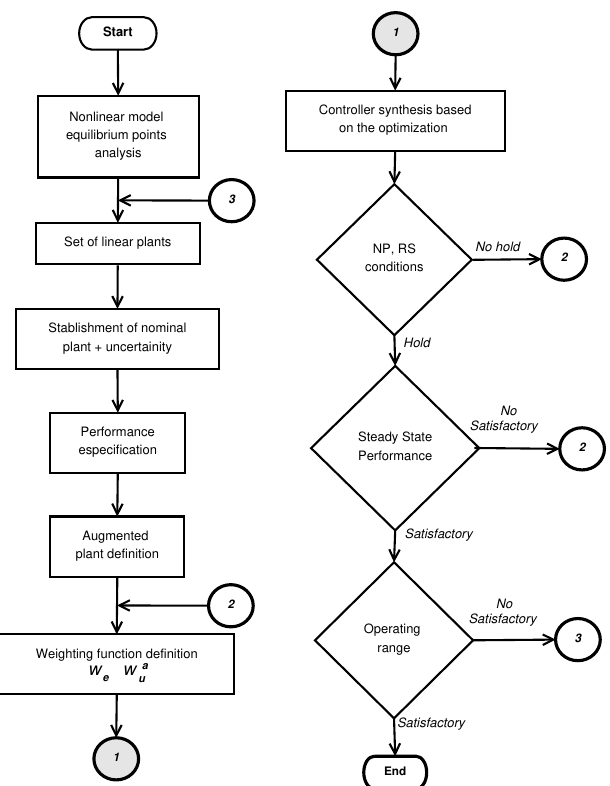
Figure 21. Proposed method to obtain a satisfactory robust controller design.